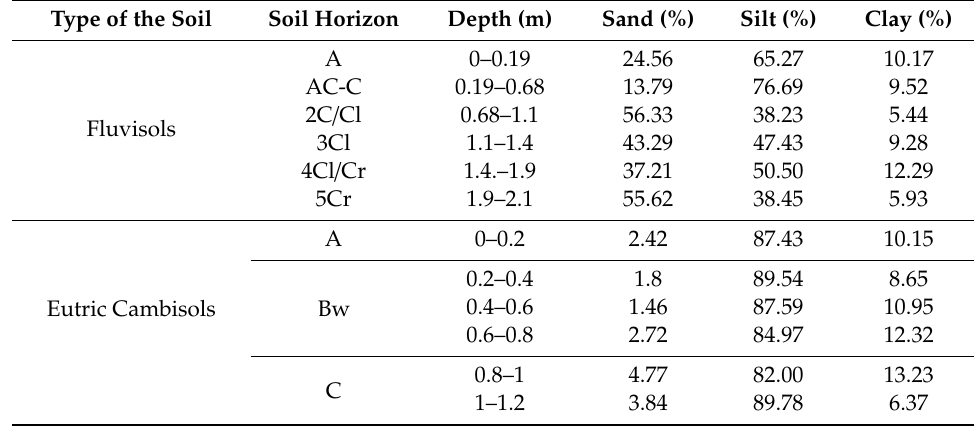
Table 2. Granulometric composition of the most common types of soils in the area of the Zagreb aquifer (modified according to